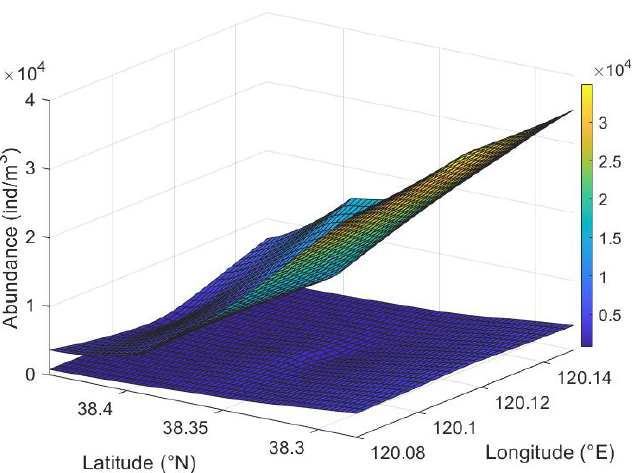
Figure 6. Distribution of the interpolated Chaetoceros concentration. The upper layer is on 15 June, and the lower layer is on 21 June.